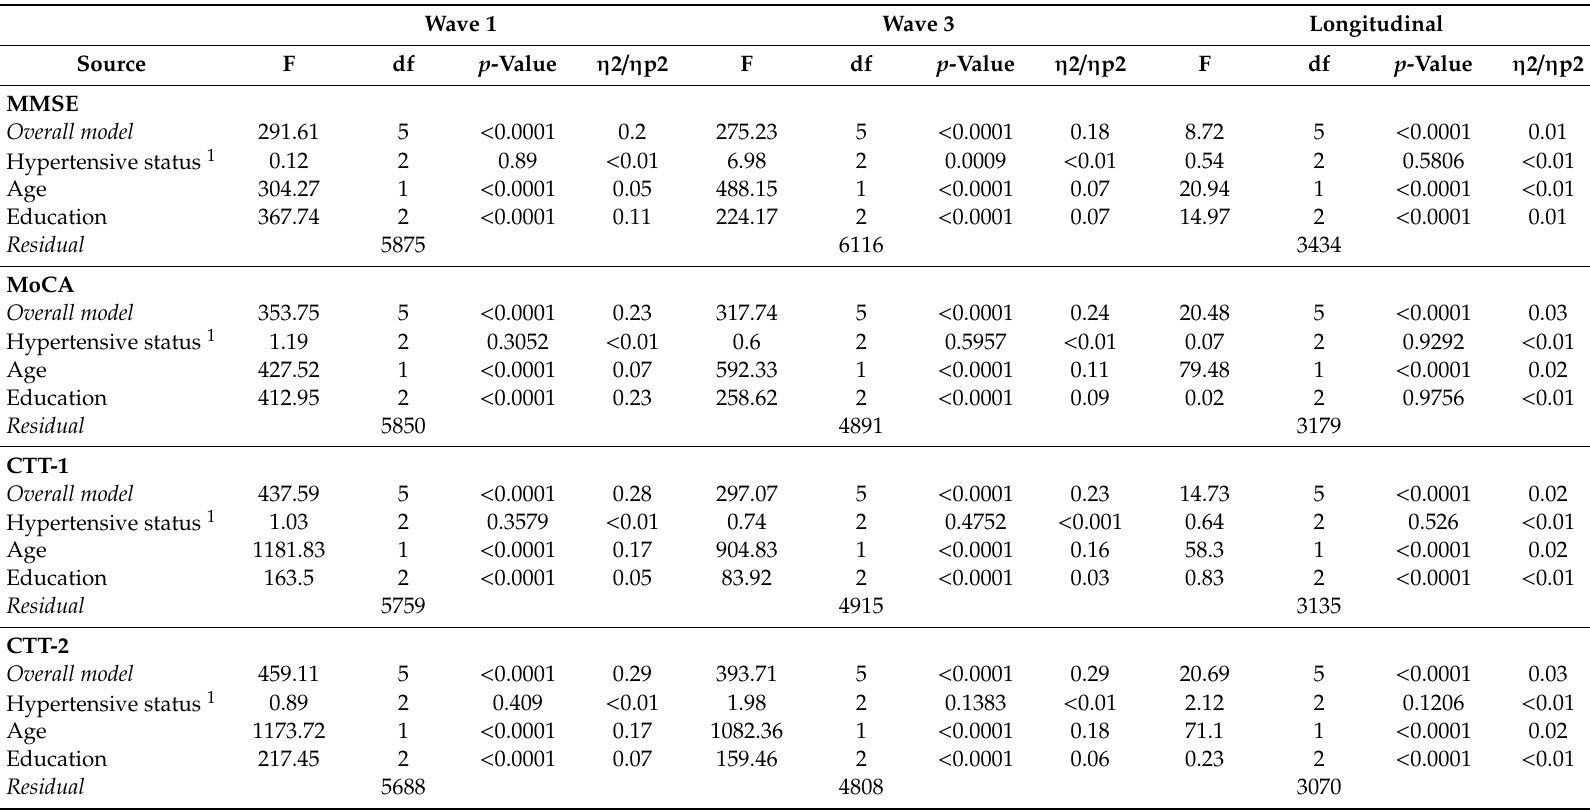
Table 3. ANCOVA results of the e ff ects of hypertensive status on di ff erent cognitive measures controlling for age and education (partial